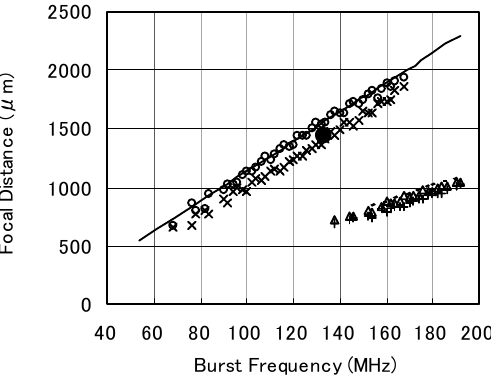
Fig.7-2 Focal Distance (Lens③×Water)